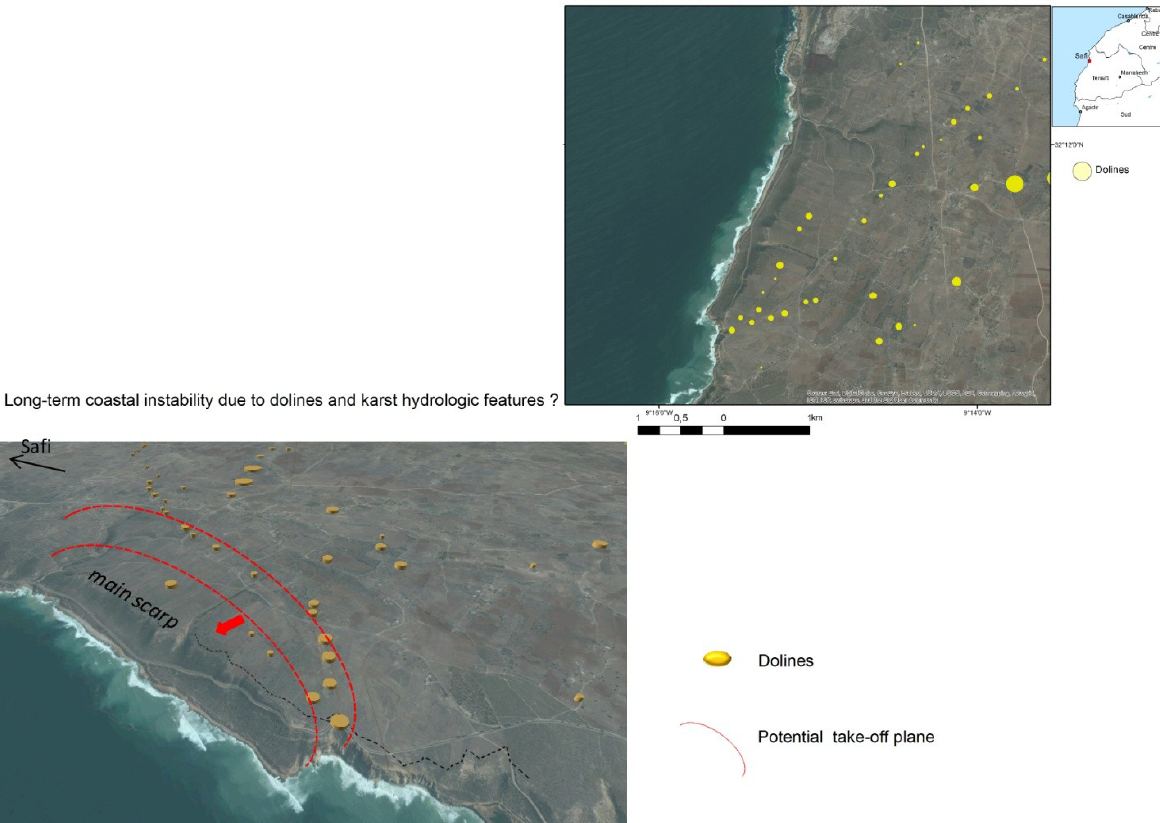
Figure 18. Perspective 3D view of near-coast dolines in the south of Safi looking towards the